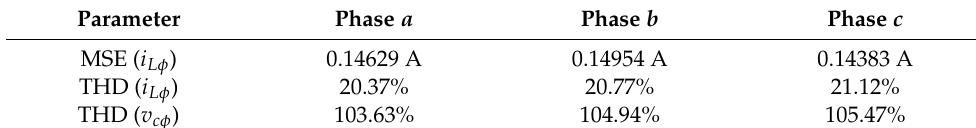
Table 6. Experimental results in the presence of parametric uncertainties.